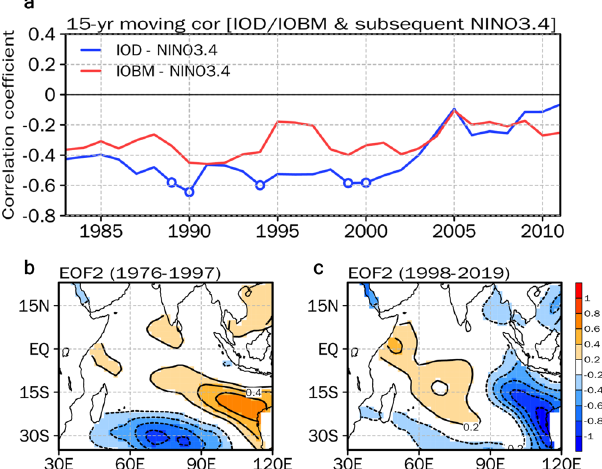
Fig. 1 | The emergence of a new climate mode over the Southern Indian Ocean afterthe 2000s. a 15-yrmoving correlationcoef fi cients betweenthe IndianOcean Dipole (IOD) index during boreal fall (SON) season, the Indian Ocean basin mode (IOBM)indexduringborealwinter(DJF)season,andthesubsequentyear ’ sNiño3.4 indexduring the DJF season (blue line: IOD vs. Niño3.4;red line: IOBM vs. Niño3.4) from 1976 − 2019. The x-axis indicates the middle year in the 15-yr moving window (e.g., 1999 indicates the correlation coef fi cient from 1992 − 2006). The dots denote correlation coef fi cients thatare statistically signi fi cant atthe 95% con fi dence level. b Second empirical orthogonal function (EOF) of sea surface temperature (SST) (°C) anomalies over the Indian Ocean during boreal late fall (OND) season for 1976 − 1997. c Asin b butfor1998 −